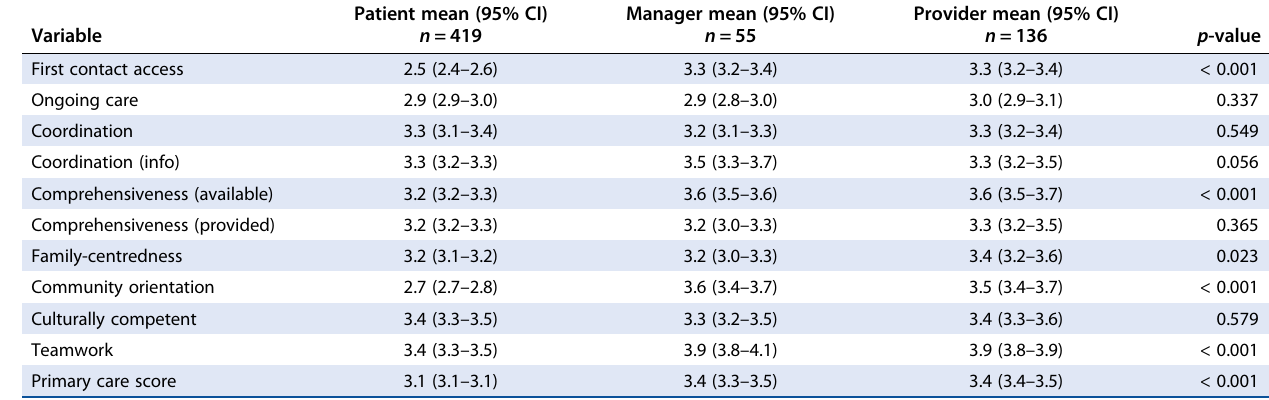
Table 3: Comparison of mean scores between respondents for different primary care domains